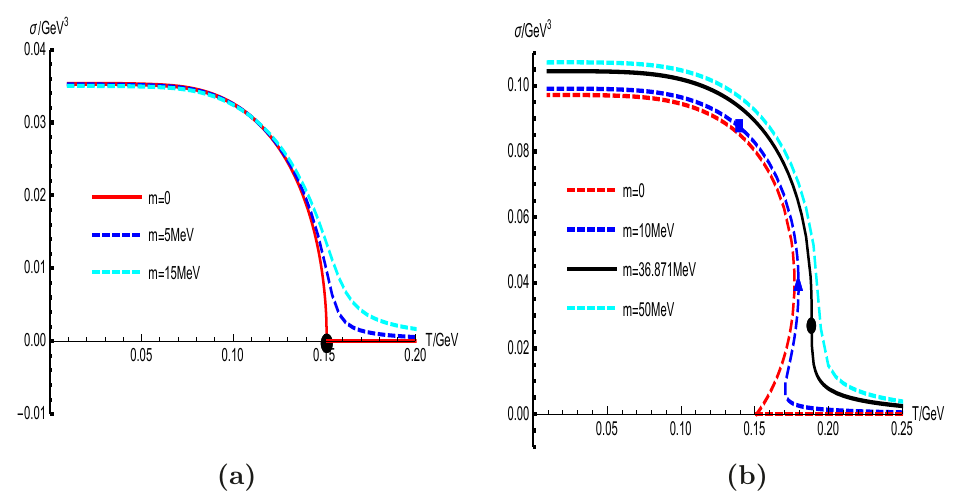
Figure 2 . Chiral condensate σ as a function of temperature T for cases N f = 2 and N f = 3. The corresponding dilaton profile are shown in eqs. (2.2)–(2.3). The metric is taken as the AdS- Schwarzchild black hole solution as shown in eqs. ( 2.5), (2.6). Panel.(a) and (b) are results solved from eq. (2.13) and eq. (2.14) respectively. In panel.(a), the results of m = 0 , 5 , 15MeV for two degenerate quarks with v 3 = 0 , v 4 = 8 are shown in red-solid, blue-dashed, cyan-dashed lines respectively. The black dot denotes the critical point of the second order phase transition at T c, 2 = 0 . 1515 . . . MeV , m c, 2 = 0 , σ c, 2 = 0. In panel.(b), the results of m = 0,10,37,50 MeV for three degenerate quarks with v 3 = 3 , v 4 = 8 are shown in red-dashed, blue-dashed, black-solid, − cyan-dashed lines respectively. The black dot denotes the critical point of the second order phase transition at T c, 3 = 0 . 1888 . . . GeV, m c, 3 = 0 . 036871 . . . GeV, σ c, 3 = 0 . 02724 . . . GeV 3 , at which dσ = . The blue rectangle and triangle dots are labeled for the description in appendix dT ∞